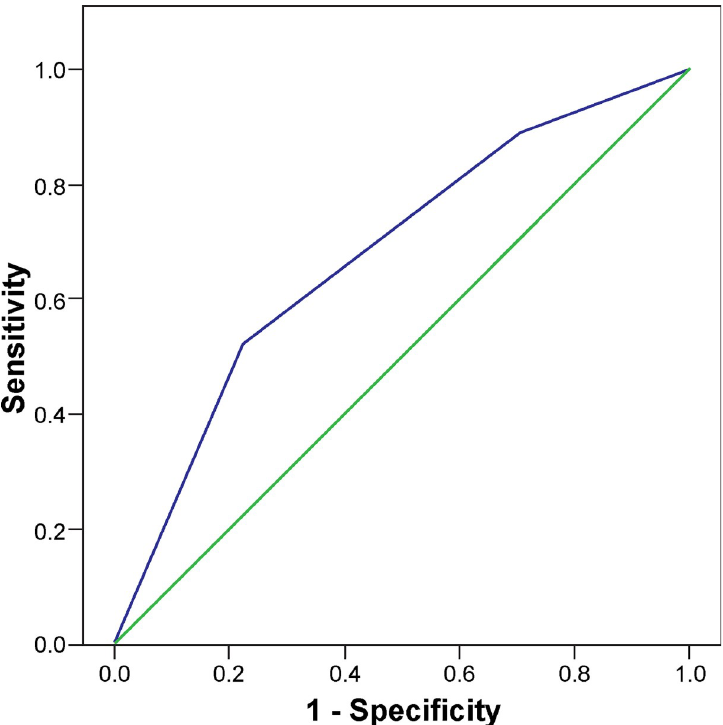
Fig 4. Receiver operating characteristic curve of the plasma-leak score for predicting plasma leakage among dengue patients.